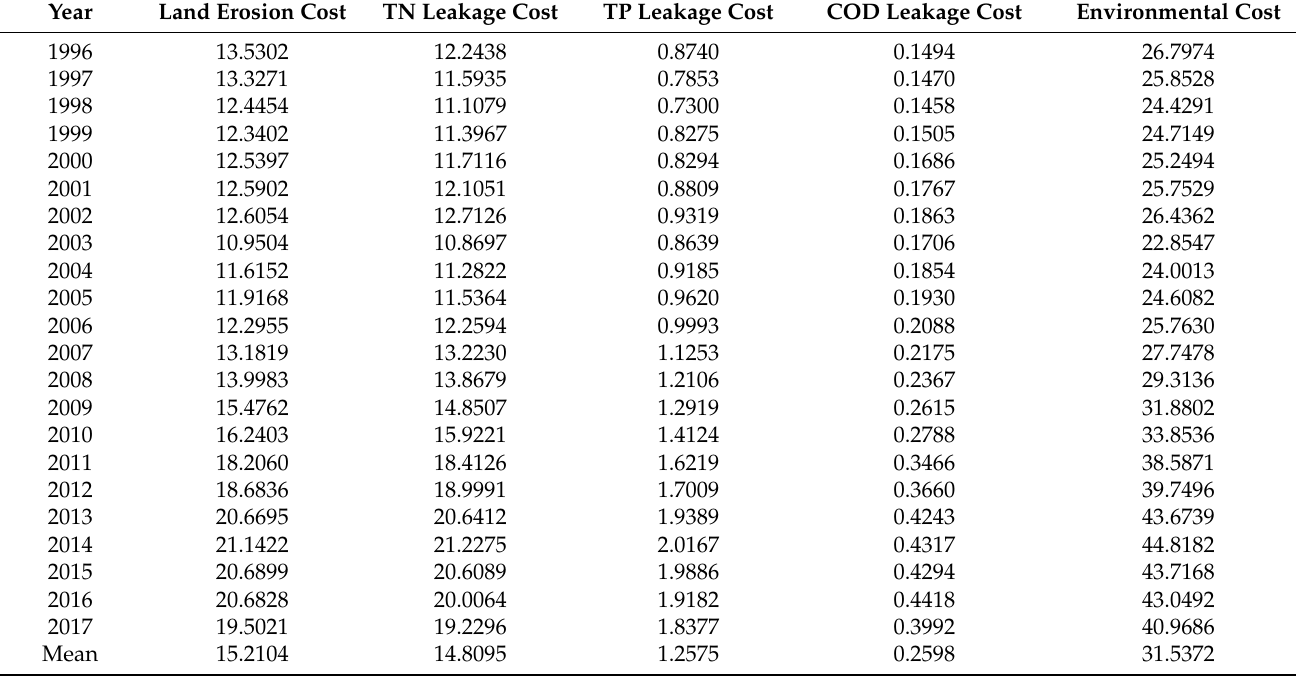
Table 7. China’s agricultural environmental cost,